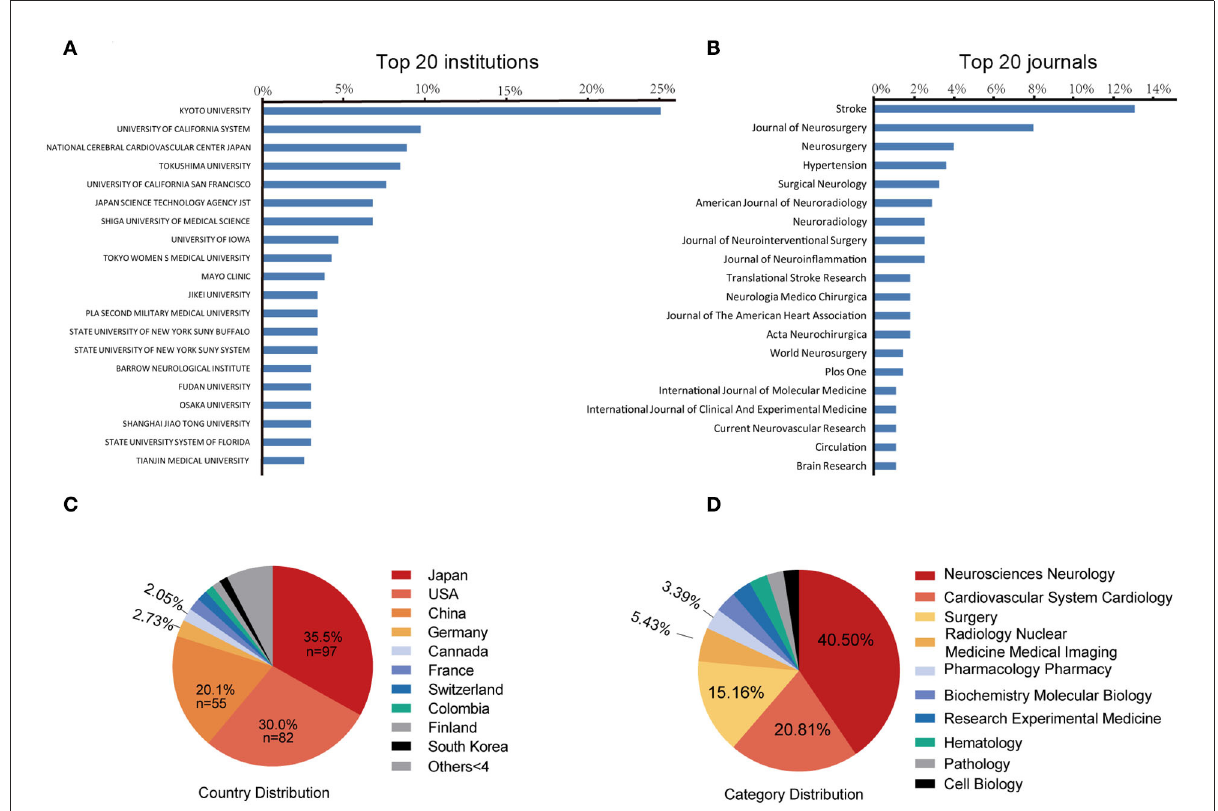
FIGURE3 The top 20 most prolific institutions (A) and journals (B) . Blue bars indicate the proportion of the total number of publications. The 10 most prolific countries (C) and research category (D) . The area of each country is proportional to the total number of publications.